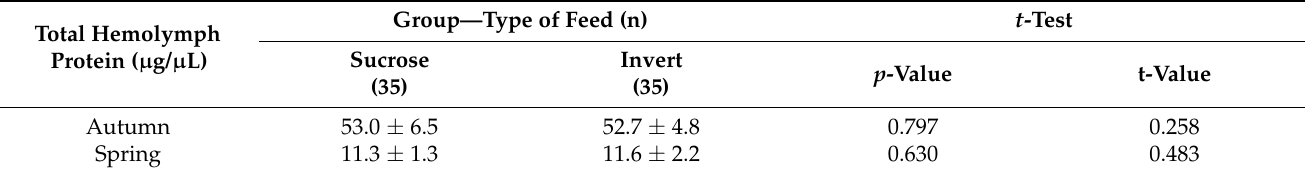
Table 6. Total hemolymph protein in autumnal and early spring honeybee workers. Differences were statistically evaluated by t -test (df = 68) and t- and p -values are presented in the last two columns. No difference was statistically significant in dependence of the used